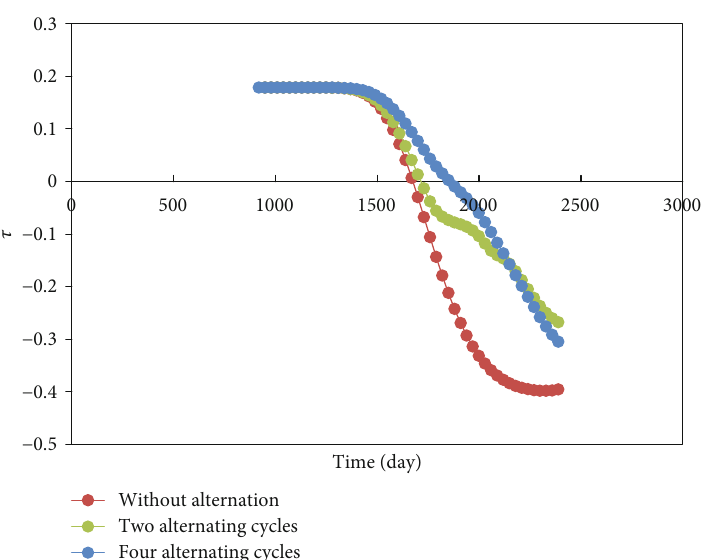
Figure 15: Water-polymer perturbation coe ffi cient with di ff erent alternating cycles.